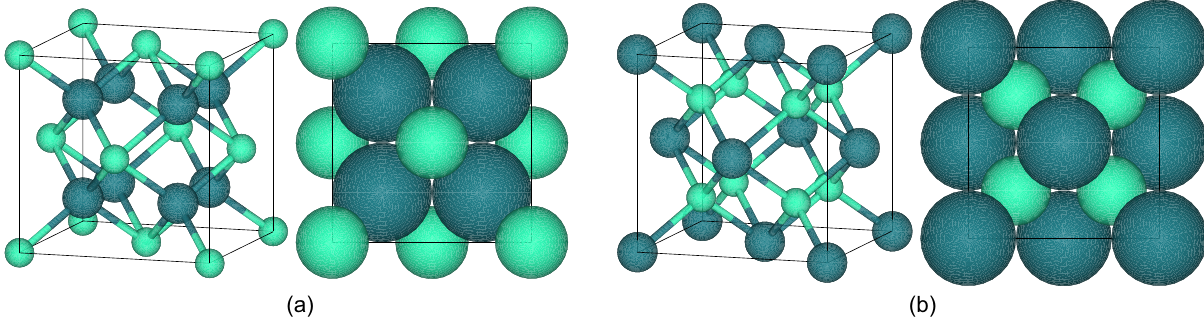
Figure 1. Unit-cell drawings of ideal ( a ) fluorite and ( b ) antifluorite structures and their respective projections (space-filling spheres) along the (100) plane. The small ocean-mint and large petrol-blue spheres represent the cations and anions, respectively.